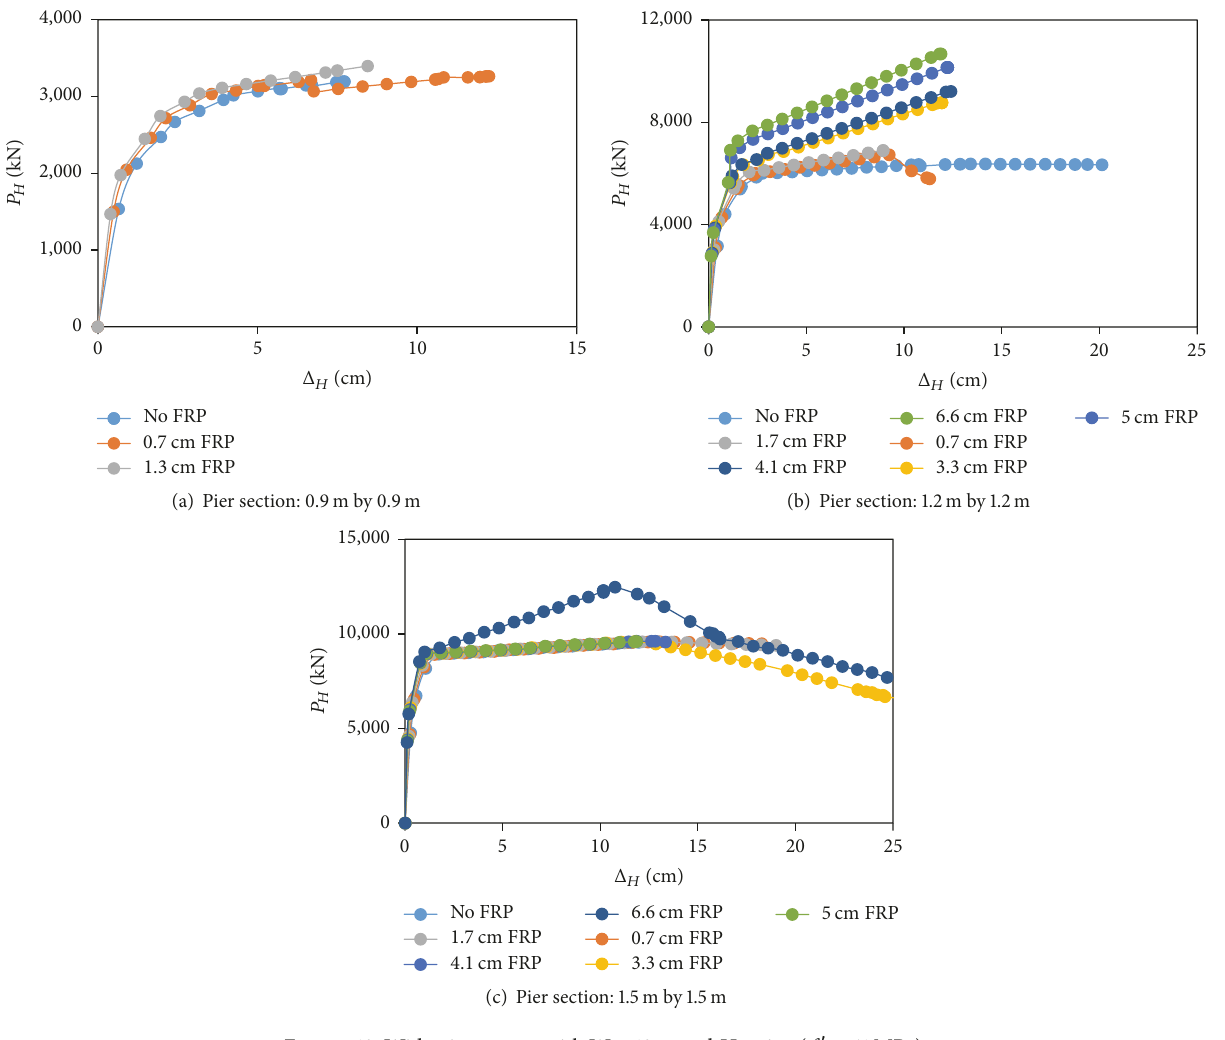
Figure 12: Wide pier system with 𝑊 = 12m and 𝐻 = 6m ( 𝑓 󸀠 𝑐 =